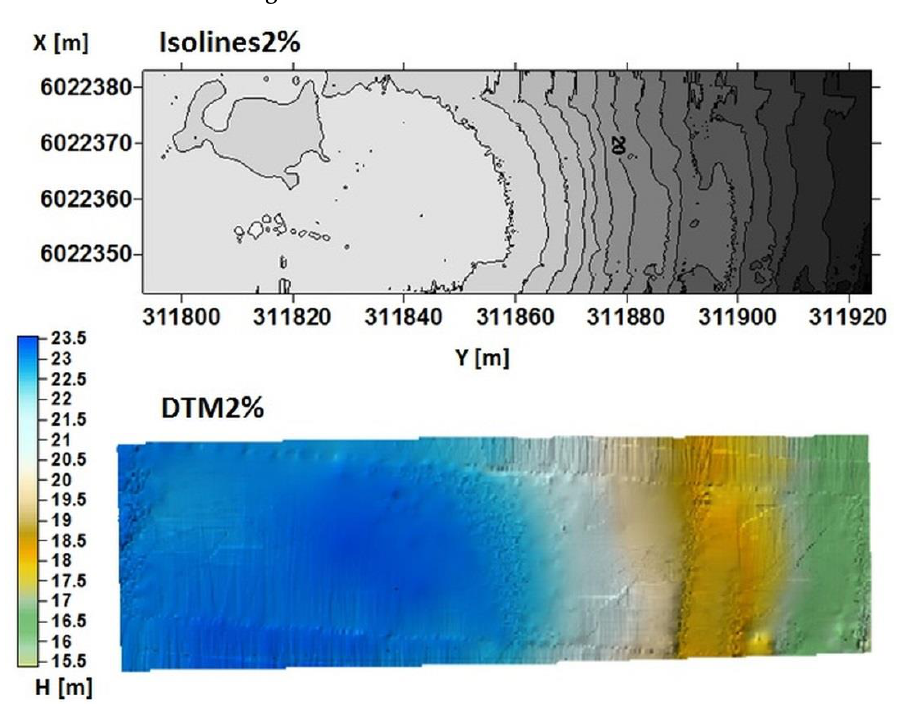
Figure 16. Isolines2% and DTM2%.